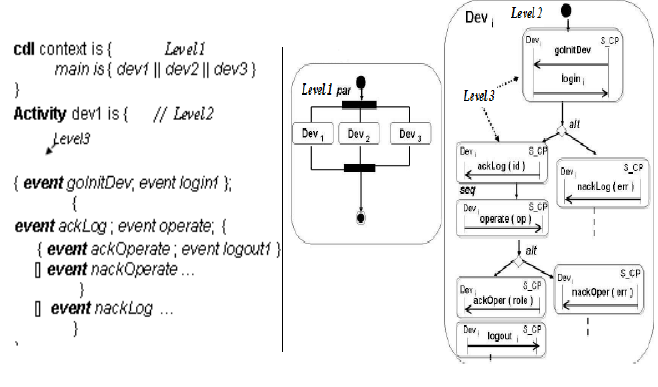
Figure1. Example of a CDL Model: Textual Vs Graphical